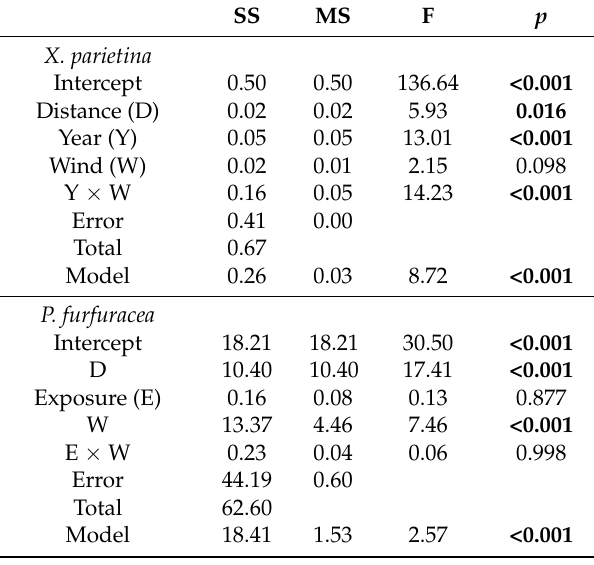
Table 3. Generalized linear model (GLM) summary statistics performed on Hg concentration values observed in samples of the lichens Xanthoria parietina (autochthonous) and Pseudevernia furfuracea (transplanted) collected or exposed in the study area during the respective biomonitoring surveys (see text). SS: sum of squares; MS: mean squares; F: F-statistic; p: p-value. Significant effect of continuous or categorical predictors are reported in bold SS MS X. parietina